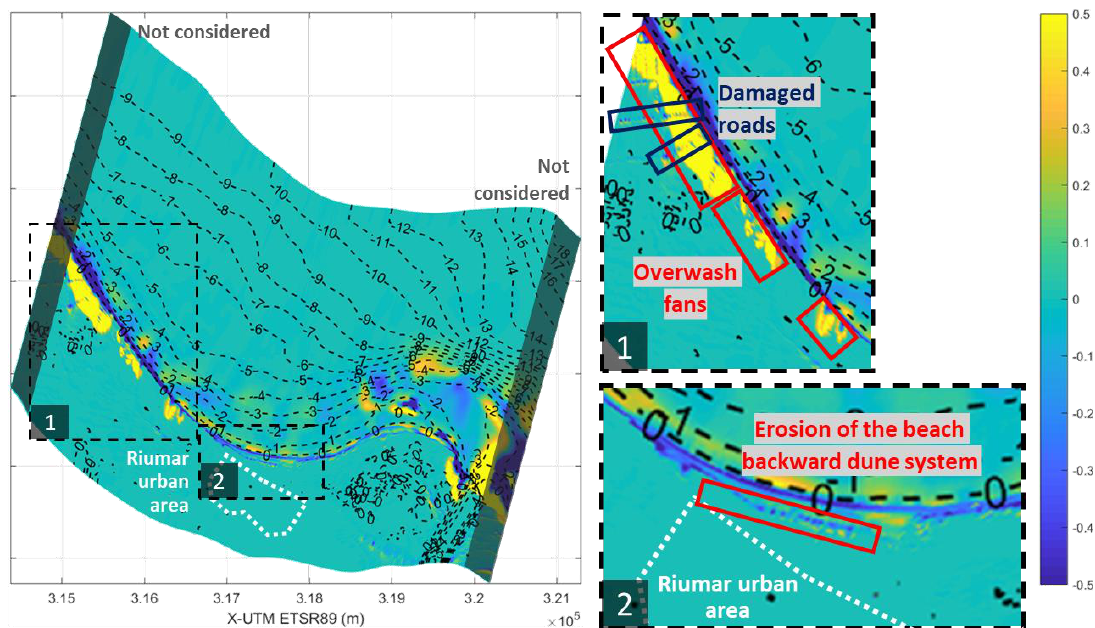
Figure 14. Post-storm erosion/accumulation patterns associated to 2100 scenario without storm surge (relative sea level rise (RSLR) = 1.03 m) due to the impact of an eastern storm of 100-year return period. The areas where sediment is eroded are colored in deep blue while the areas where sediment is accumulated are shown in light yellow. Color bar (units in meters): in deep blue, accumulated erosion throughout the simulation; in light yellow, accumulated accretion. The shadowed western and eastern areas were not considered at the eroded volume quantification.